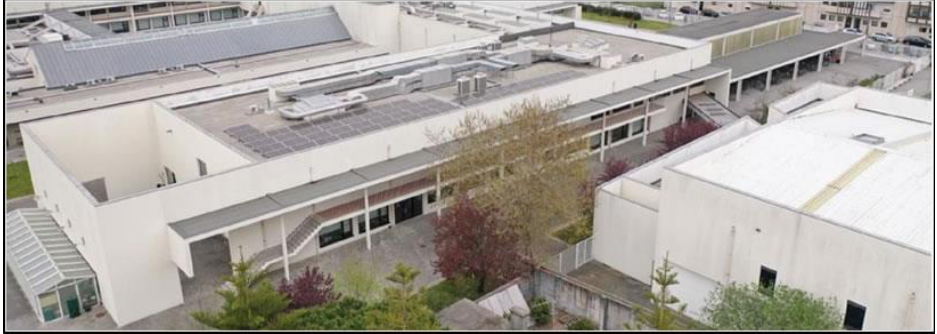
Figure 13. Solar panels installed on the roof of the target-school.